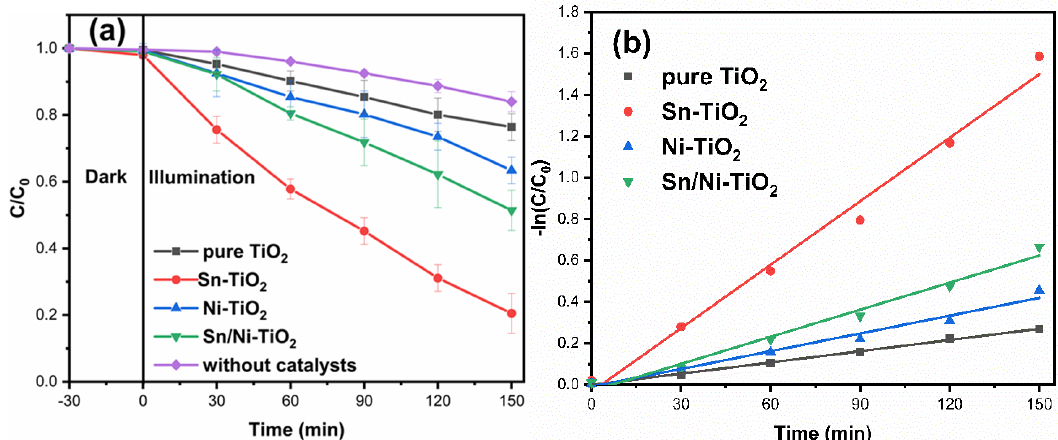
Figure 7. Decolorization degree curves ( a ) and kinetics curves ( b ) of samples.